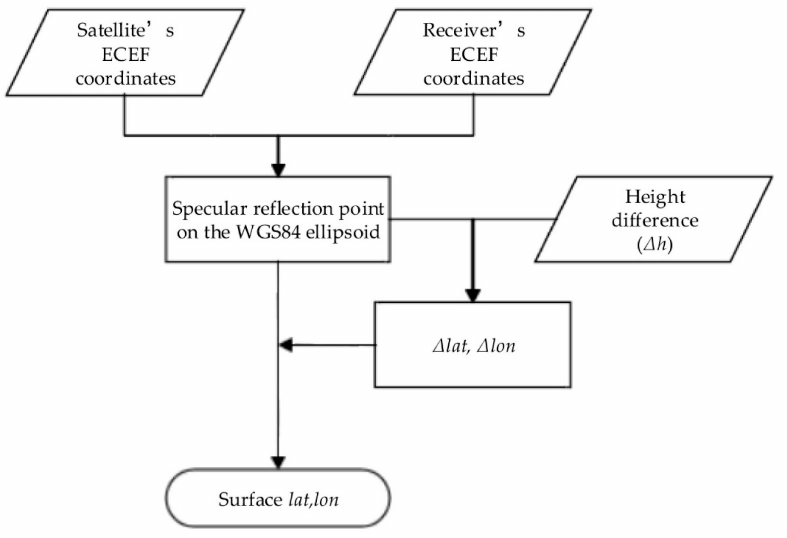
Figure 3. Calculation procedure of the specular reflection point in GNSS-R.